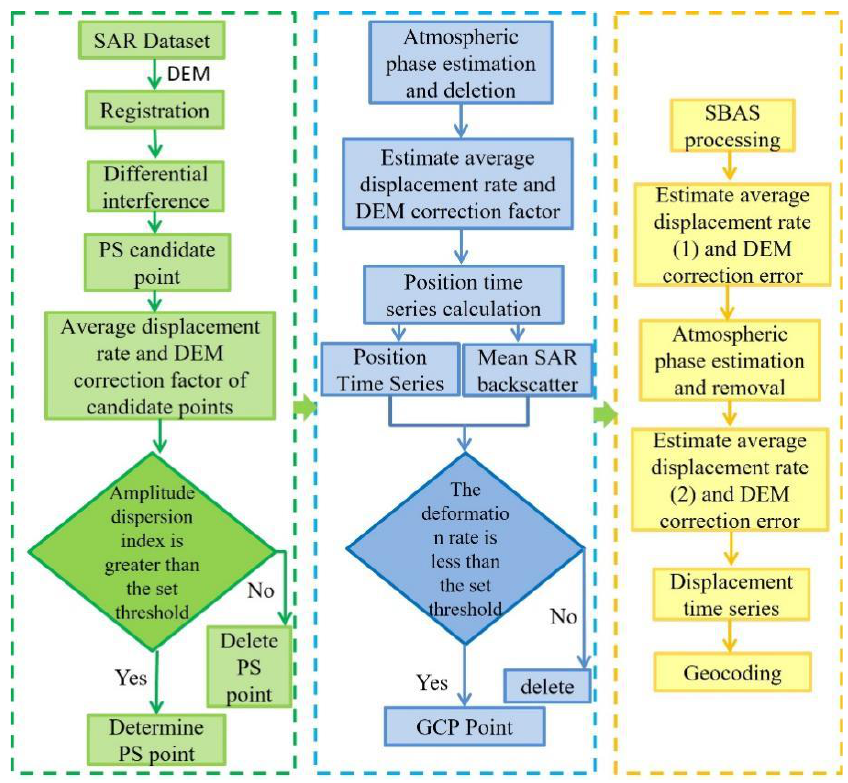
Figure 2. SBAS-InSAR technology framework integrating PS technology.